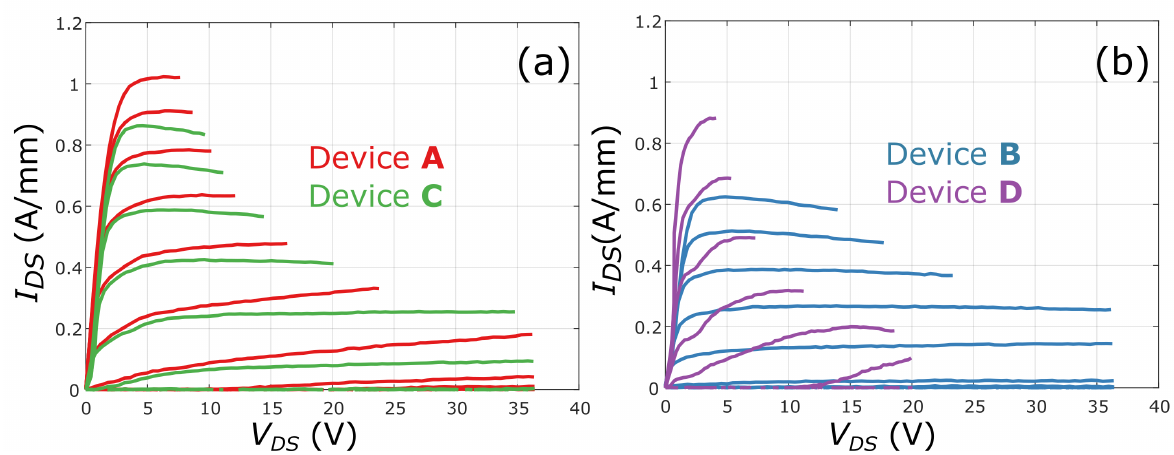
Figure 1. Output static characteristic for the four devices-under-tests (DUTs) at 40 ◦ C. ( a ) Device A and C , V GS swept from − 5 V to 0 V in 0.5 V increments. ( b ) Device B and D , V − 3.5 V to 0 V in 0.35 V increments. GS swept from